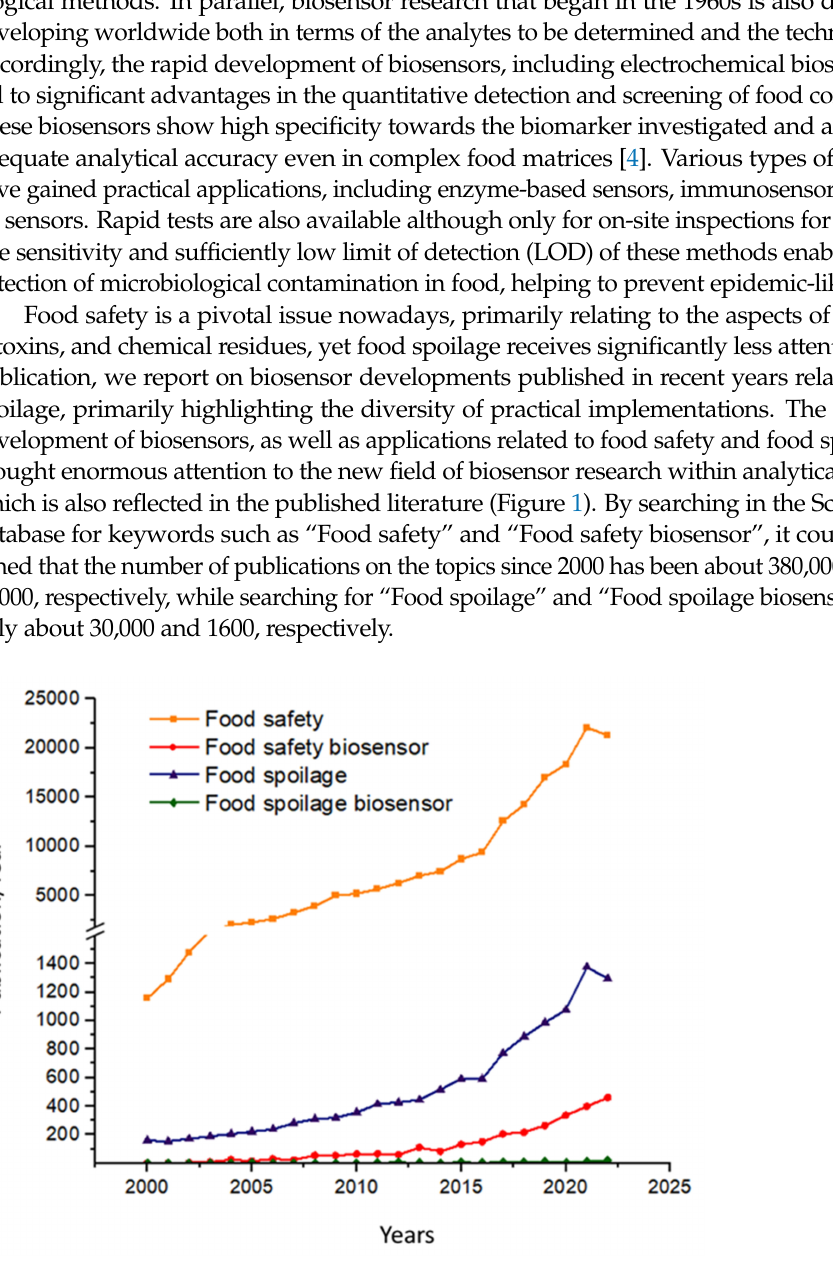
Figure 1. Number of papers published annually during the past two decades found using the keywords “Food safety”, “Food safety biosensor”, “Food spoilage”, and “Food spoilage biosensor” from the Web of Science database (accessed on 21 March